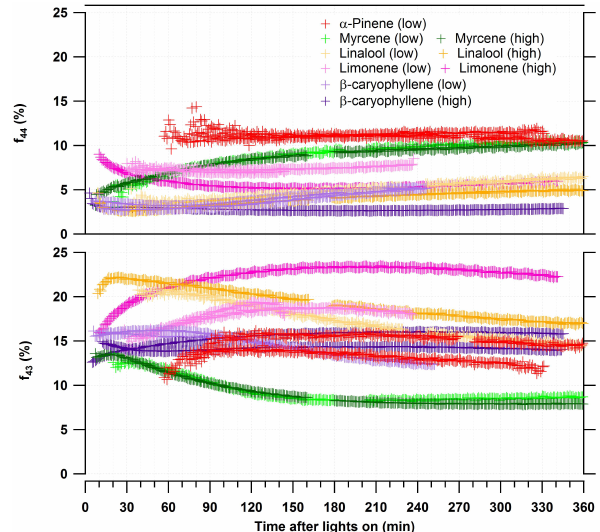
Fig. 3. Evolution of the f 44 and f 43 with photooxidation for low and high initial VOC mixing ratio